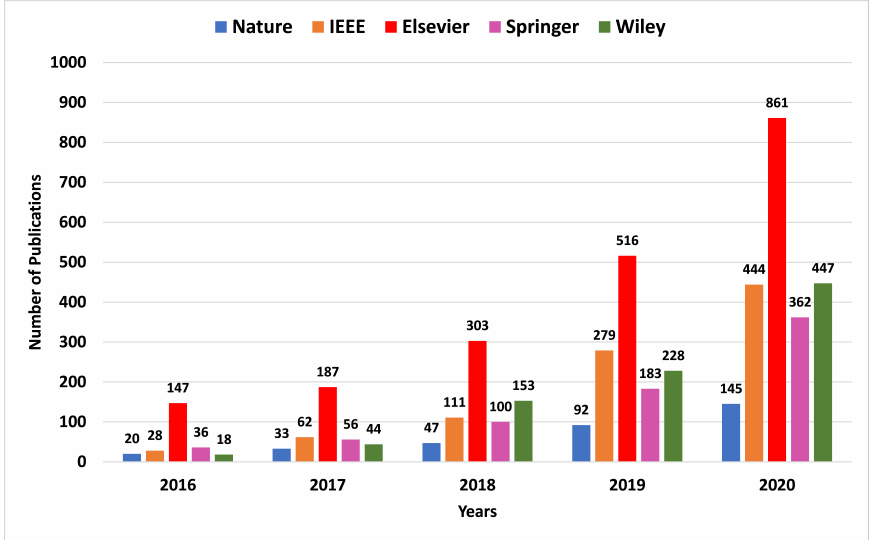
Figure 2. A comparison of publication records for DL-based IoT/IIoT